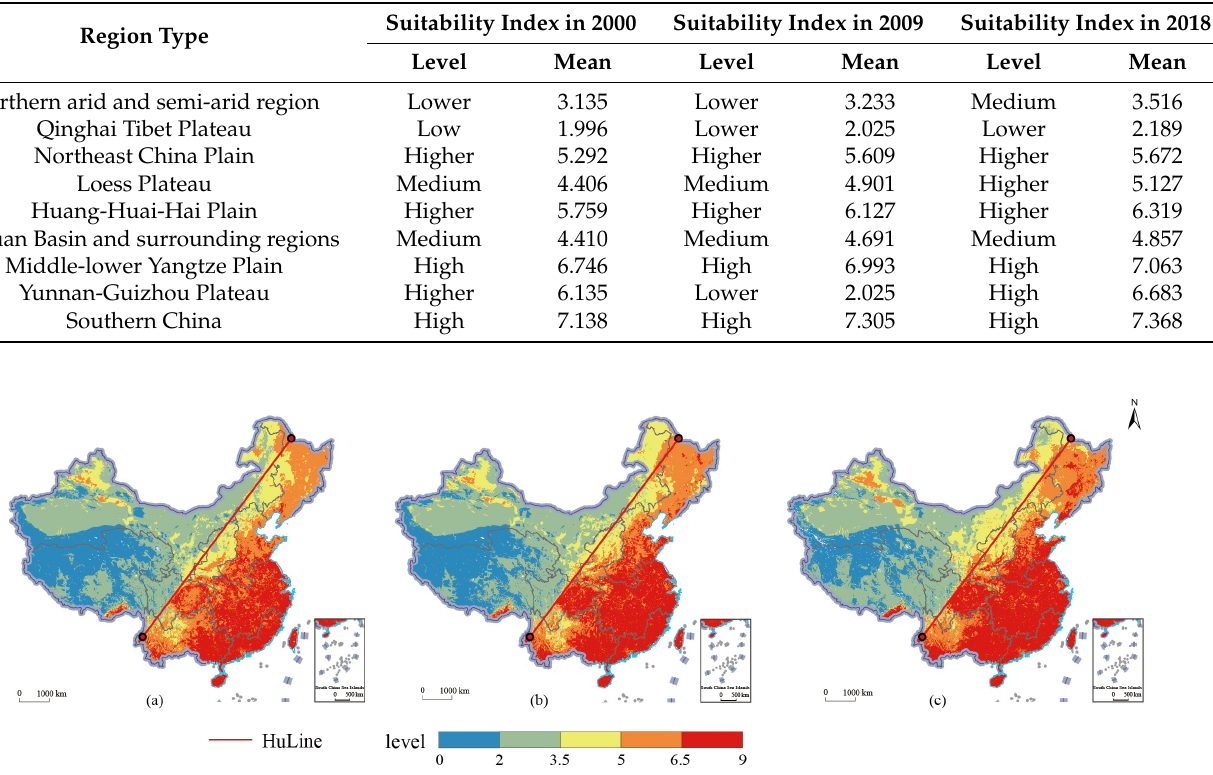
Figure 2. Spatial distribution of agricultural production space suitability in 2000, 2009 and 2018. ( a ) agricultural production space suitability in 2000; ( b ) agricultural production space suitability in 2000; ( c ) agricultural production space suitability in 2018.